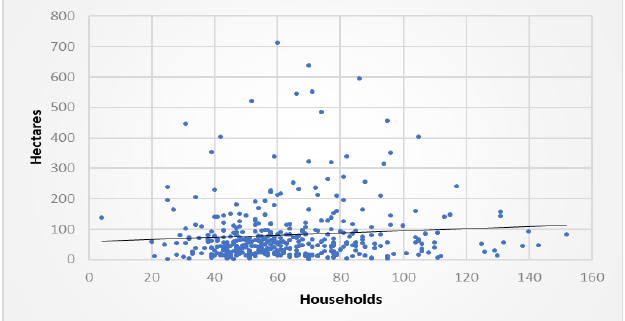
Fig. 9. The relationship between RT ’ s Area and its households